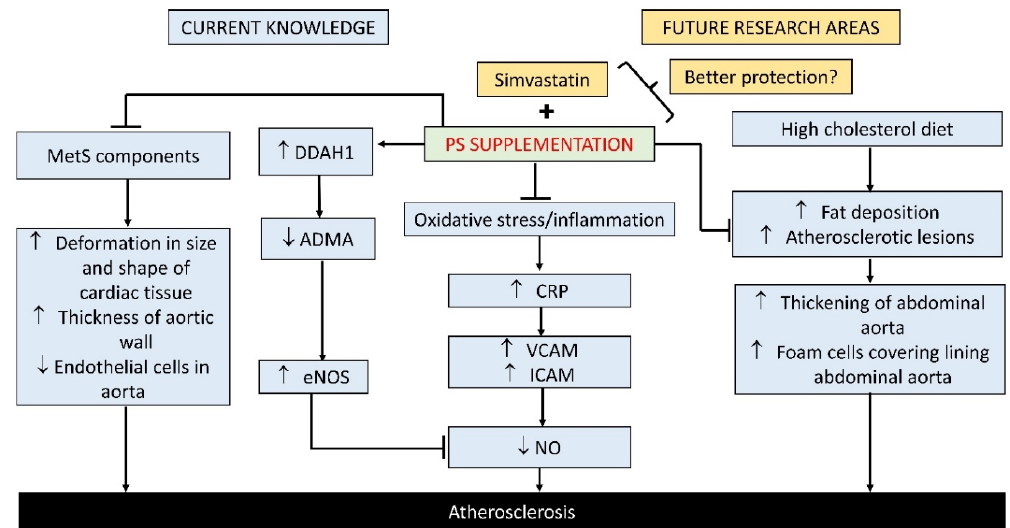
Figure 6. Protective effect of PS supplementation against dyslipidaemia/hyperlipidaemia: current knowledge and future area of investigation. List of abbreviation: PS, Piper sarmentosum ; ↑ , increase; ↓ , decrease; +, in combination; DDAH-1, dimethylarginine dimethylaminohydrolase 1; ADMA, asymmetric dimethyl arginine; NO, nitric oxide; eNOS, endothelial nitric oxide synthase; CRP, C-reactive protein; VCAM, vascular cell adhesion molecule-1; ICAM, intercellular adhesion